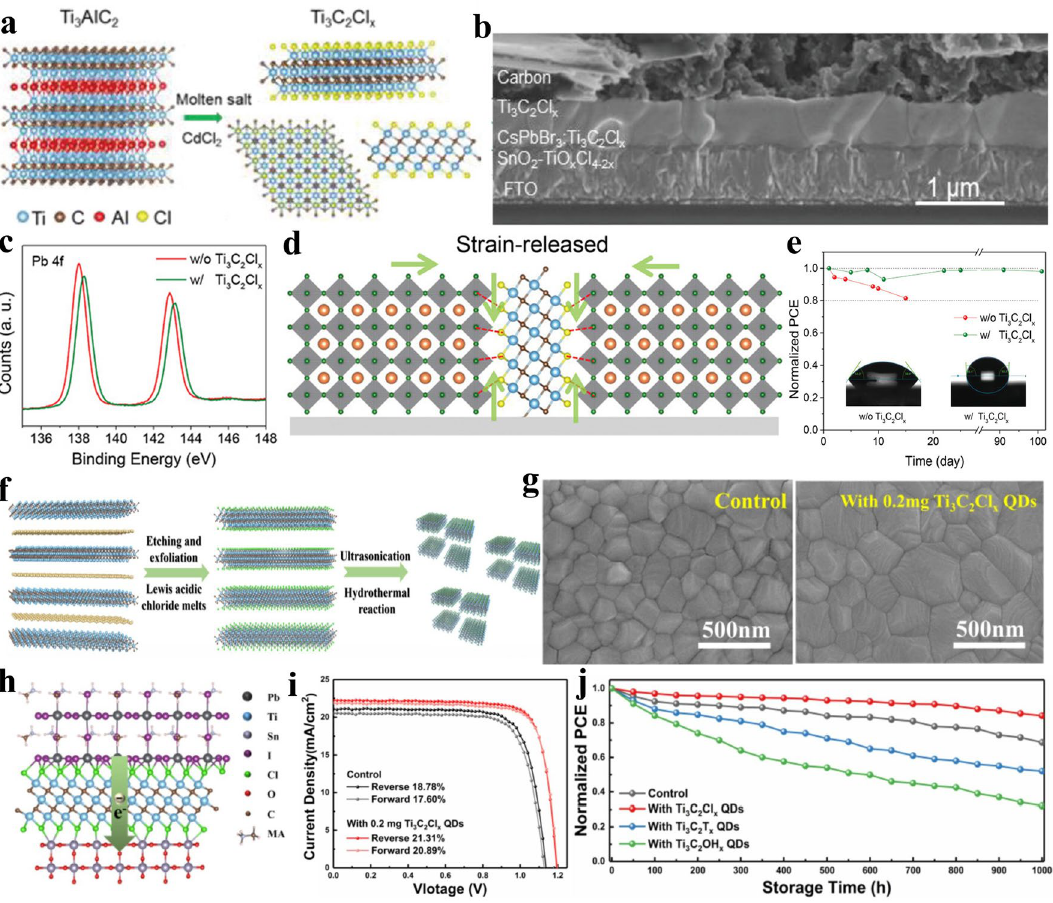
Fig. 15 a Schematic showing the preparation of Ti 3 C 2 Cl x MXene. b Cross-sectional SEM image of all-inorganic PSCs. c Pb 4f XPS spectra of CsPbBr 3 perovskite film. d Schematic of released strain in the CsPbBr 3 grains with Ti 3 C 2 Cl x MXene. e Long-term stability of the devices in air under 80% relative humidity and 25 °C. Reproduced with permission from [159] Copyright 2021, The Authors, published by Wiley–VCH. f Schematic demonstrating the preparation of Ti 3 C 2 Cl x QDs. g SEM images of pristine and Ti 3 C 2 Cl x QDs-modified perovskite films. h Sche- matic illustration of the perovskite-Ti 3 C 2 Cl x QDs-SnO 2 heterojunction. i Reverse and forward scans for the pristine and Ti 3 C 2 Cl x QDs-modified devices. j Normalized PCEs against storage time for the pristine and Ti 3 C 2 Cl x QDs-treated devices. Reproduced with permission from